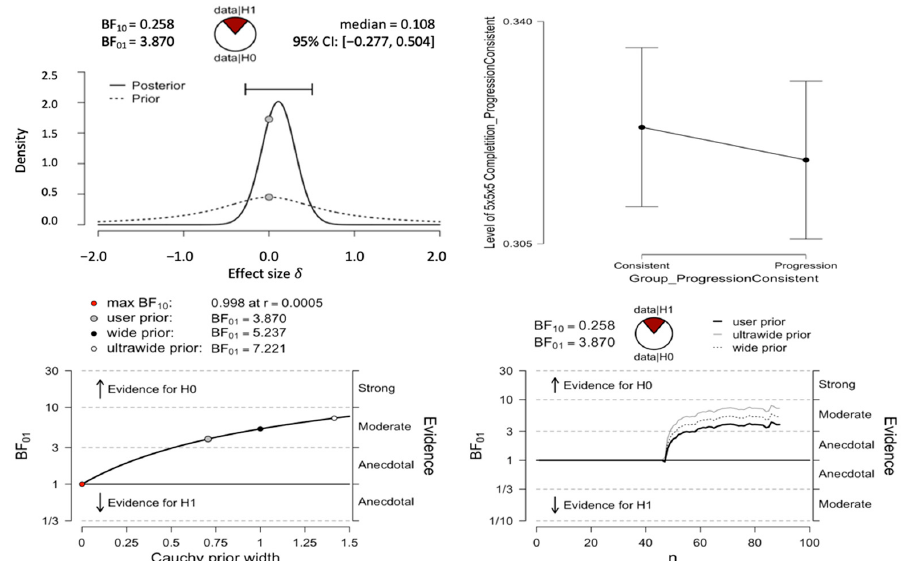
Figure 7. Results of Bayesian t -test for the progression-order and consistent-order groups. The top-left pane shows prior and posteriors densities. The top-right pane shows the descriptive plot. The bottom-left pane shows the Bayes Factor Robustness check. The bottom-right pane shows the sequential analysis.